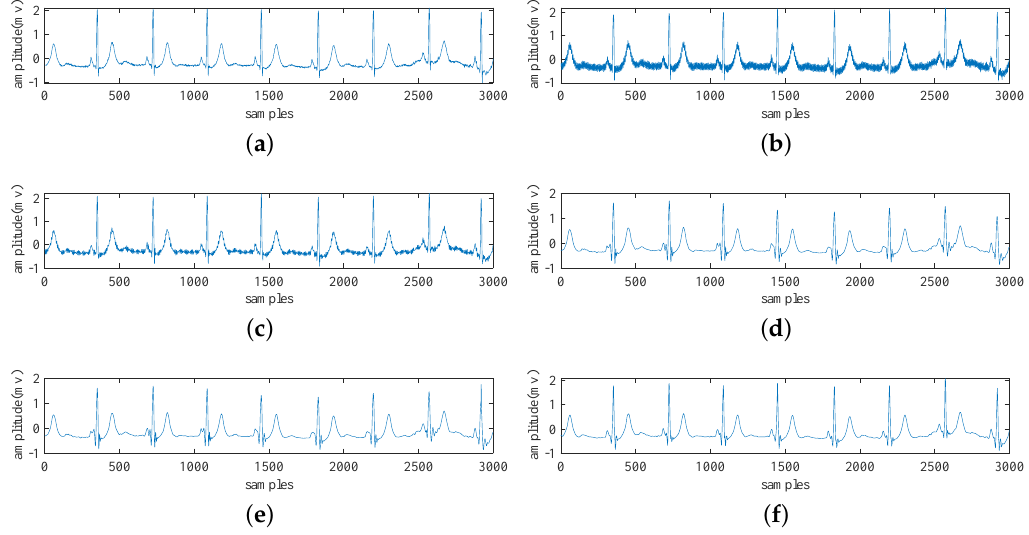
Figure 5. The de-noising results of signal added 50 HZ power line interference to the 106 record of the MIT-BIH database: ( a ) The original signal. ( b ) The signal after adding power line interference. ( c – f ) De-noised signals using wavelet soft threshold, EMD, EMD soft threshold, proposed method.